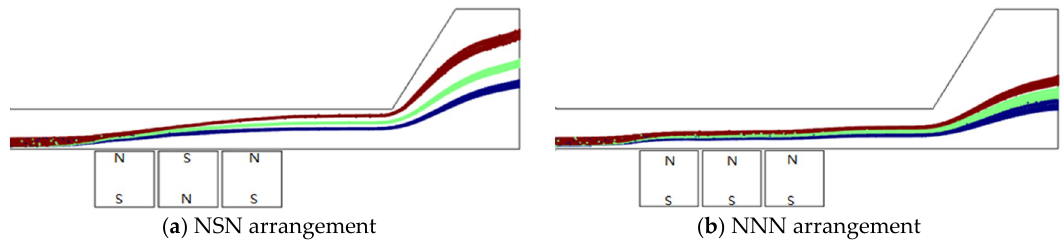
Figure 6. Particle trajectories for various magnetic pole distributions. (a) NSN, (b) NNN.